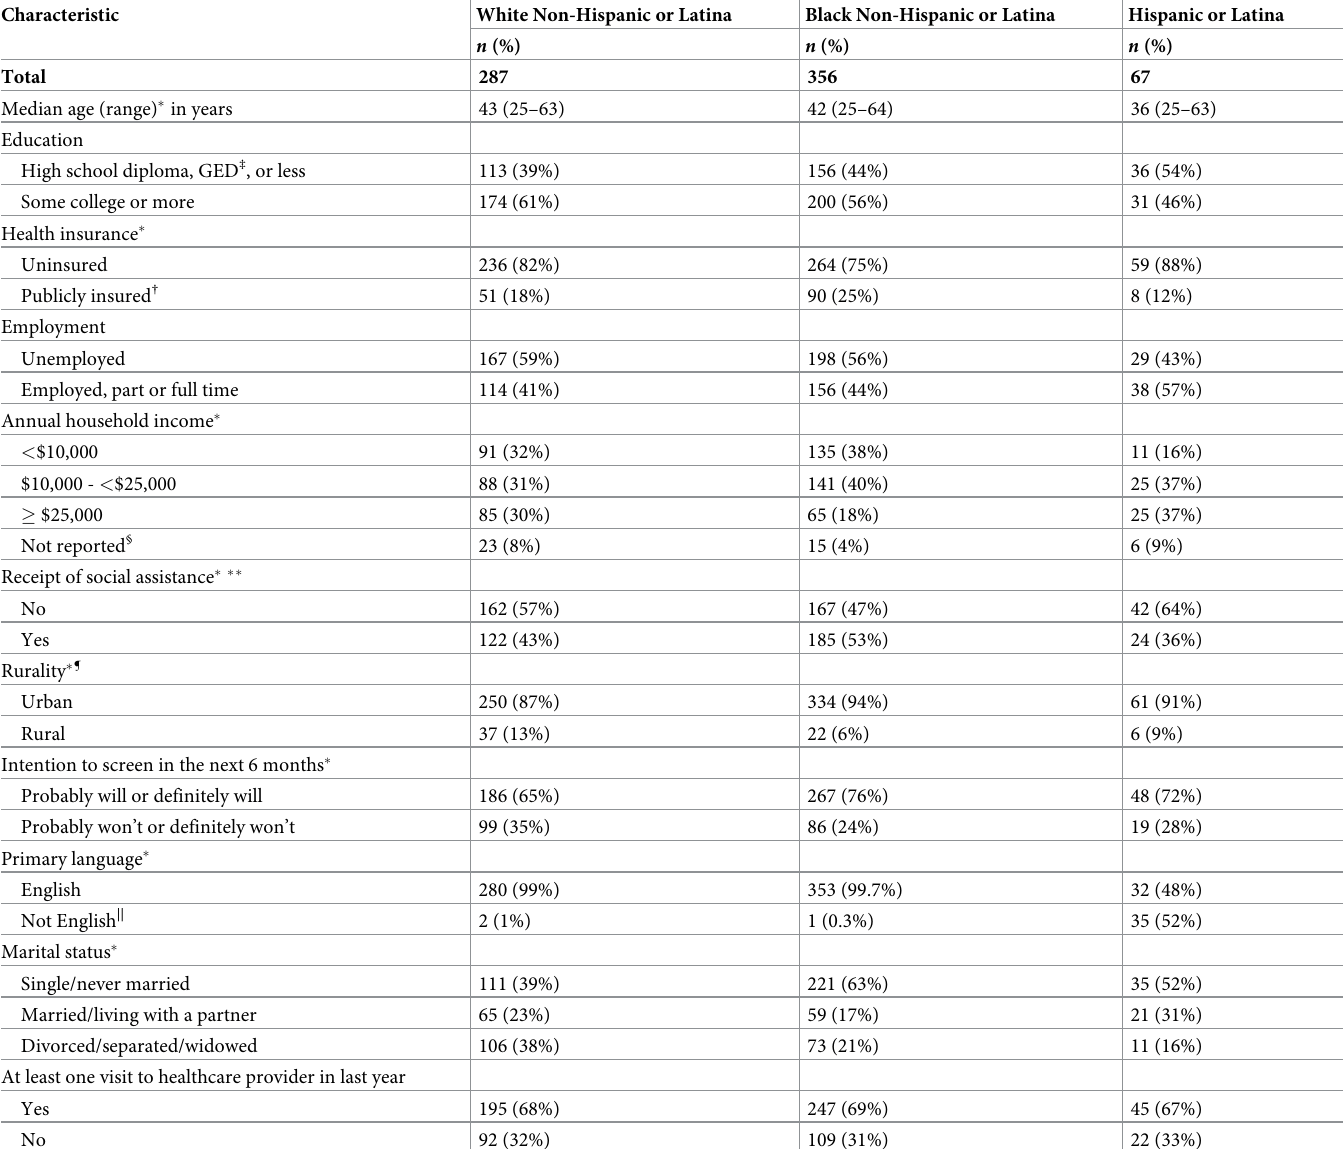
Table 1. Characteristics of My Body My Test-3 study participants, stratified by race and ethnicity ( n =